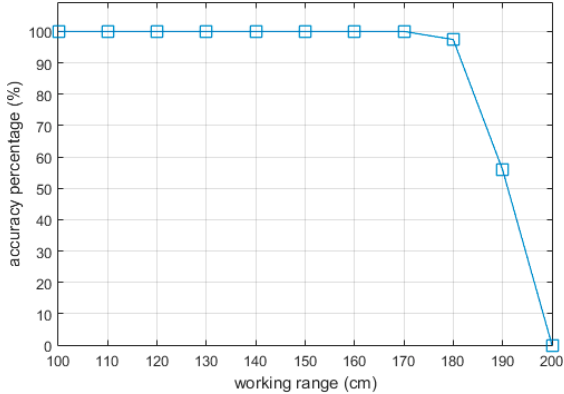
Figure 10. Working range accuracy.